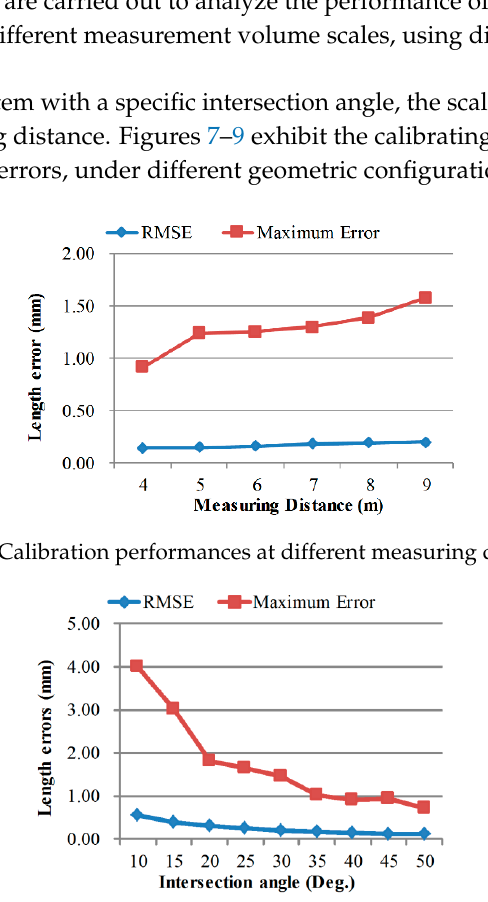
Figure 8. Calibration performances under different camera intersection angles.